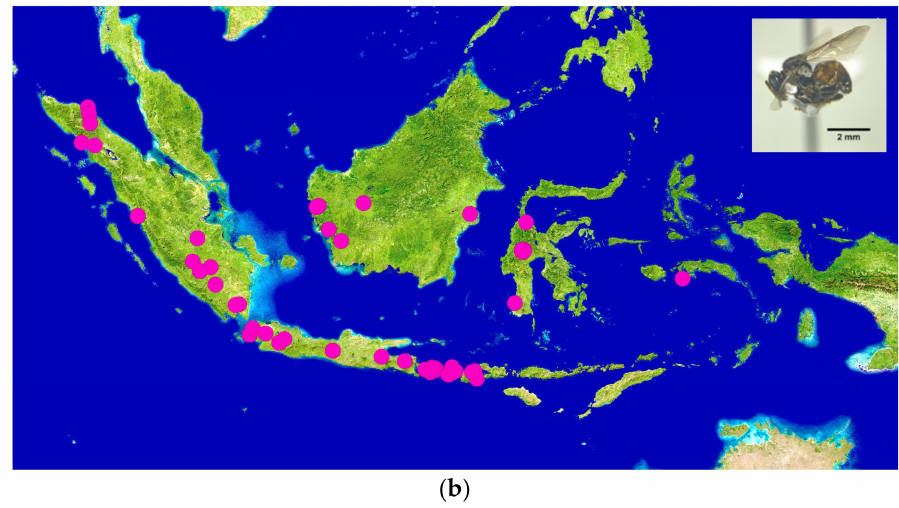
Figure 6. Distribution map of the most dominant bees, ( a ) Apis cerana and ( b ) Tetragonula laeviceps .